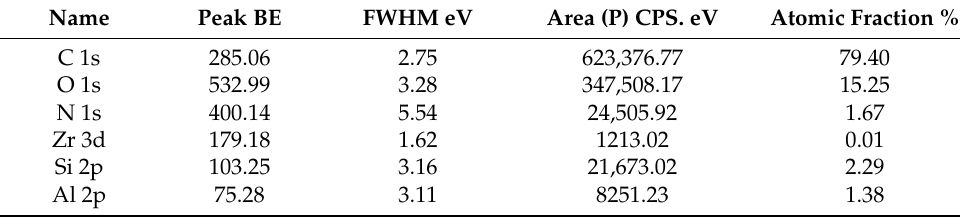
Table 2. Relative contents of different atoms based on XPS wide scan spectrum.